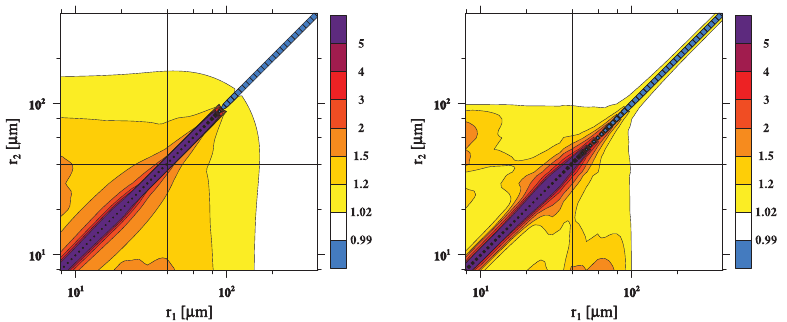
Figure 5. Ratio of the turbulent coagulation kernel to the Hall kernel in the turbulent flow with Re λ = 127 and (cid:15) = 400cm 2 s − 3 . (a) Ayala– Wang kernel and (b) the present Onishi kernel.